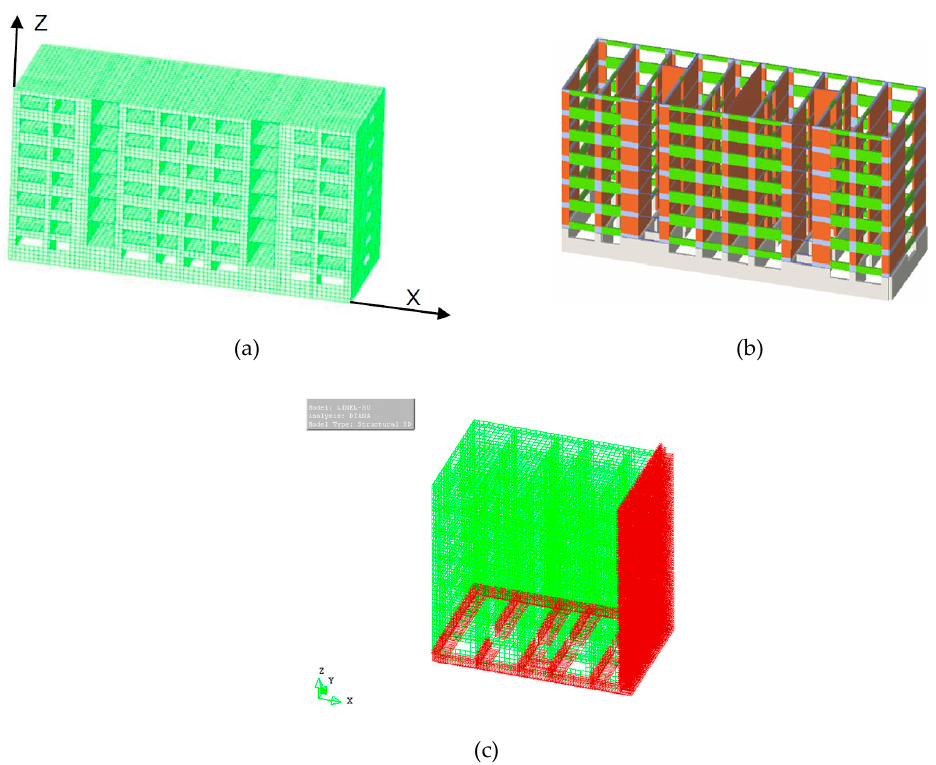
Figure 5. Models used for safety assessment: ( a ) Finite element model (FEM) in DIANA; ( b ) EFM in 3MURI; ( c ) FEM model in DIANA (only half is modelled to keep the computational effort acceptable). Table 2. Constrain Summary.